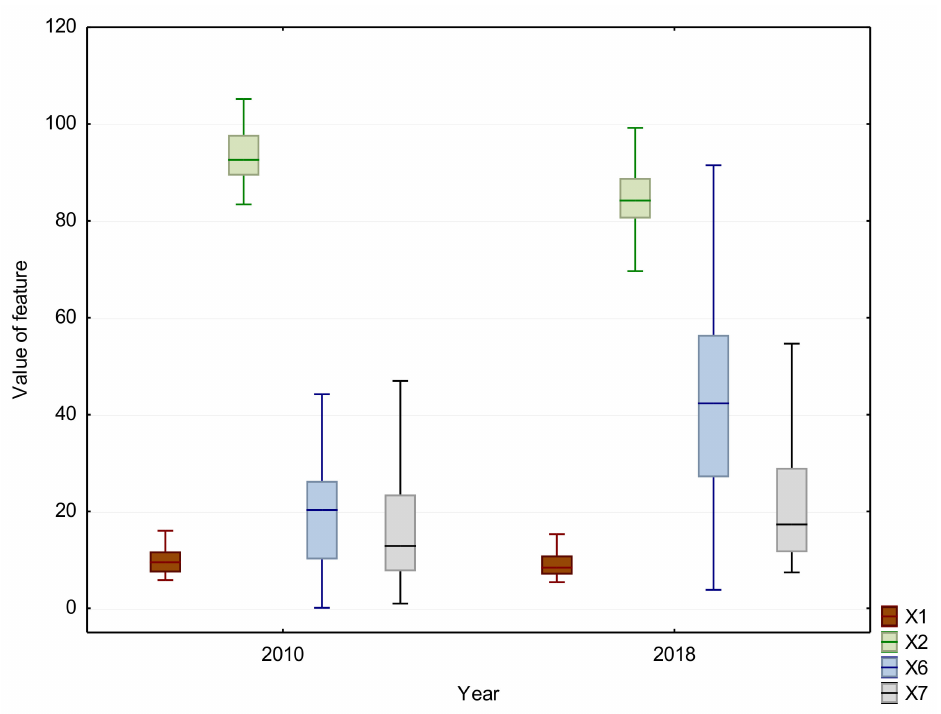
Figure 1. Distribution of the value of features for